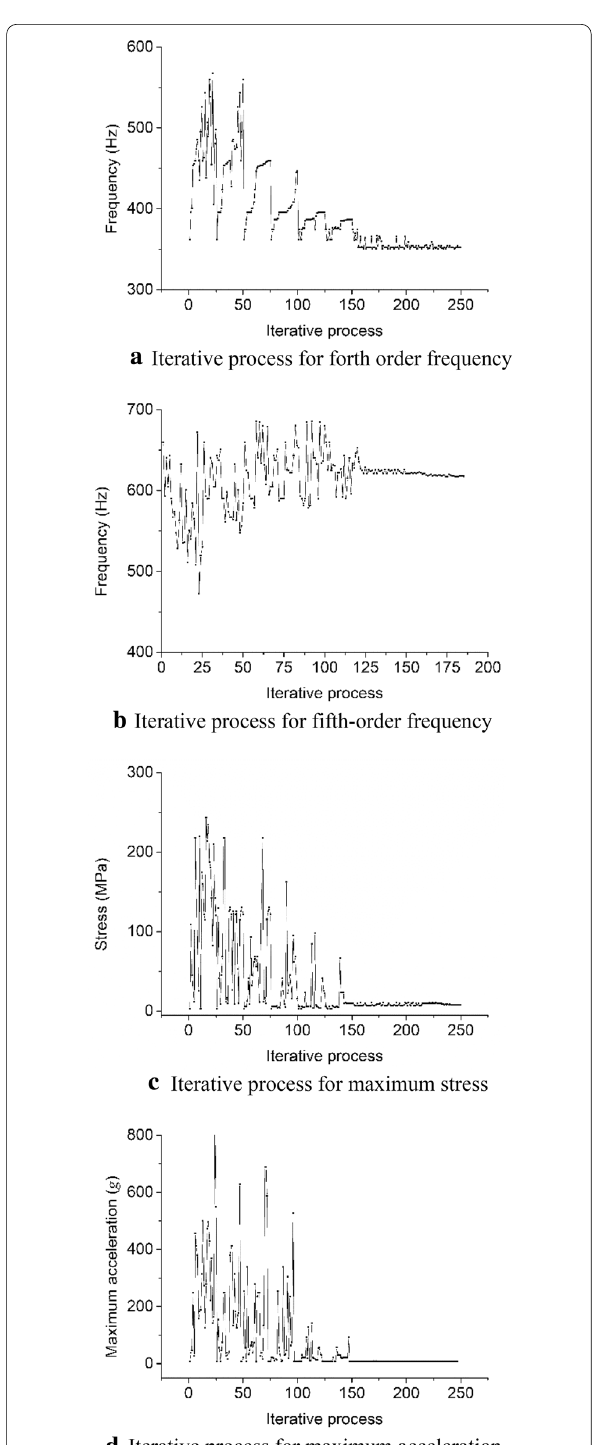
Figure 9 Iterative process for optimization calculation. a Iterative process for forth order frequency. b Iterative process for fifth-order frequency. c Iterative process for maximum stress. d Iterative process for maximum acceleration